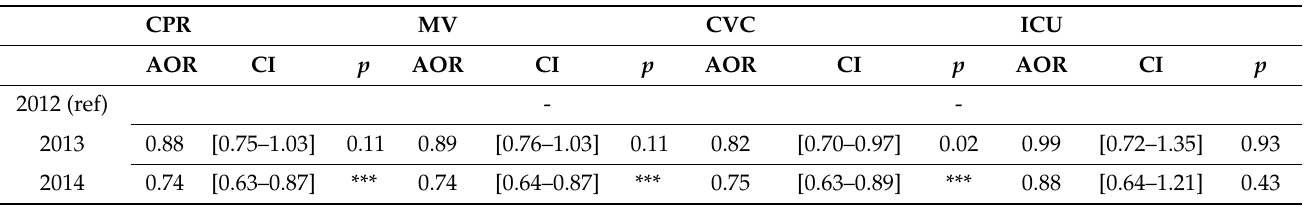
Table 3. Annual decreases in the odds of receiving life-sustaining treatments and intensive care unit admission in the last 7 days of life from 2012 to